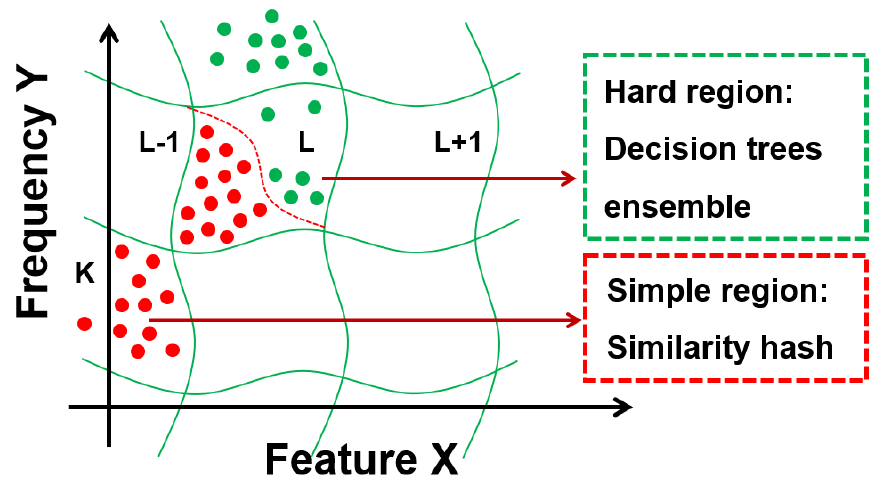
Figure 4. ML: segmentation of object space.